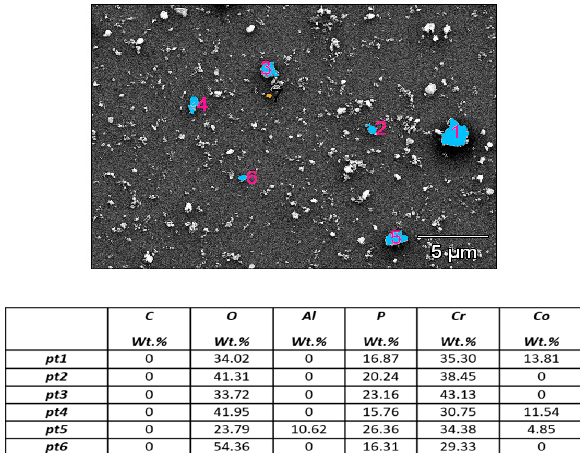
Figure 5. Secondary electron images of wear particles. Particles were collected from wear corrosion tests performed in PBS containing 3 g/L HA (PBS-HA) and deposited on silicon wafer to analyze the chemical composition of detached particles. Blue colors represent the particle where EDS has been performed and the particle number shown in pink is correlated to the pt shown in the table attached. Table 1. Statistical analysis by Kruskal–Wallis test for the chemical composition (wt %) of wear particles detached during wear corrosion tests of CoCr samples in PBS (condition number 1), PBS+ 3 g/L HA (condition number 2) and under anodic potentiodynamic polarization (condition number 3), where n is the number of samples, mean is the average value, SD is the standard deviation, C25 is the value of the 25% of the data, C75 is the value of the 75% of the data, and p * is the significant difference at 0.95 confidence level.